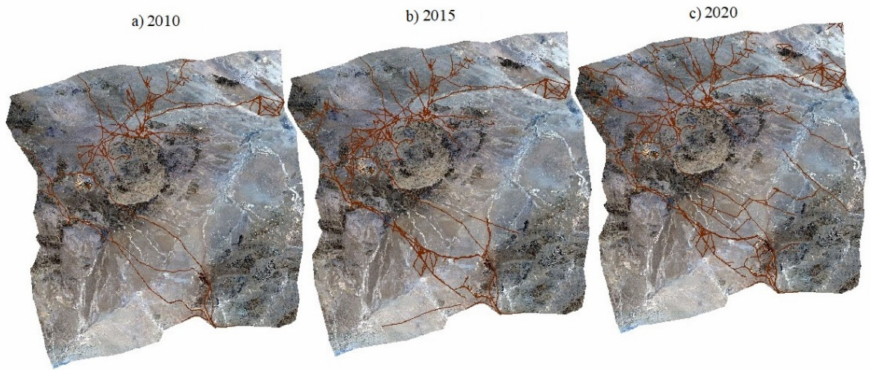
Figure 4. Spatial extent of soil roads within Khanbogd soum for